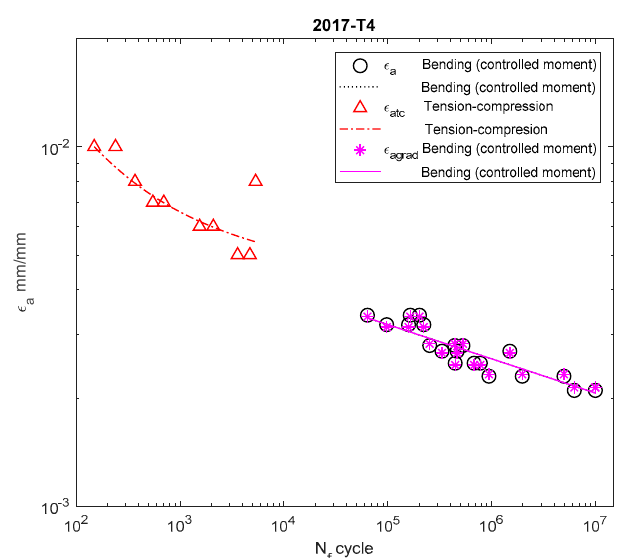
Figure 11. Dependency chart for the strain amplitude ε a = f ( N f ) for 2017A-T4 aluminum alloy.